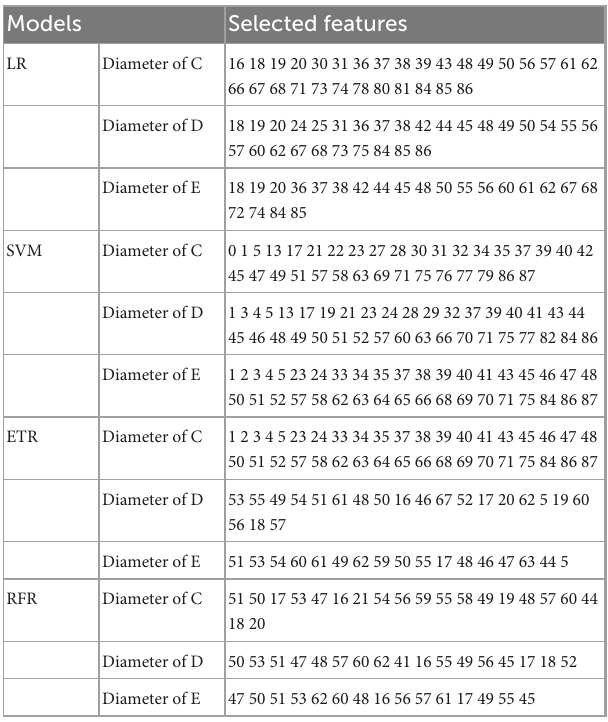
Frontiers in Cardiovascular Medicine